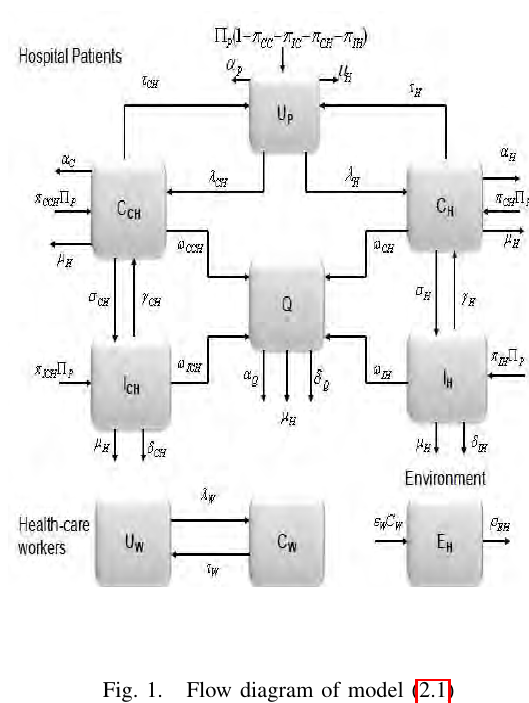
Fig. 1. Flow diagram of model